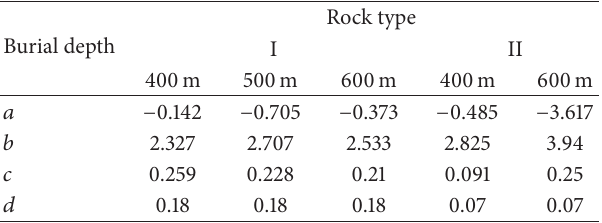
Figure 16: The relationship between 𝑢/ℎ and 𝜆𝛾𝐻/𝐸 ( 𝑑 = 0.07 and 𝐺 = 40 GPa). Table 6: Fitting parameters in (12).